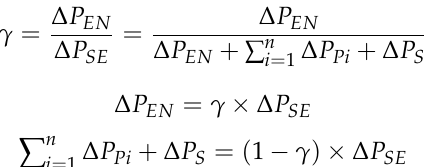
Figure 2. Combined pressure distribution of thermal, wind, and HVAC systems.